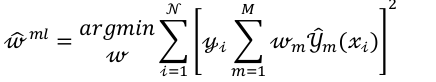
Algorithm 2. The Steps of the Proposed MLHM.